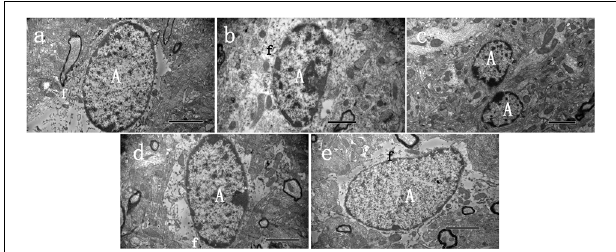
FIGURE 2 | Ultrastructural characteristics of astrocytes 48 h after cerebral ischemia. Representative transmission electron microscopy images of astrocytes in the peri-infarct area of stroke, at 48 h after cerebral ischemia, in three groups of animals. (A) Normal astrocyte was observed in sham group, (B) Swollen activated perineuronal and perivascular astrocytes were seen in model groups, which demonstrated activation as evidenced by a significant amount of chromatin condensation atop the nuclear membrane and large nucleolus. The astrocytes were characterized by dispersed residual organelles and swollen mitochondria. Astrocyte fusion was often observed (C) . (D,E) Less damage was observed in the EGB treatment group. A astrocyte, f—fibrils. Bars: A , C , D , E 2 µ m; B 1 µ m.